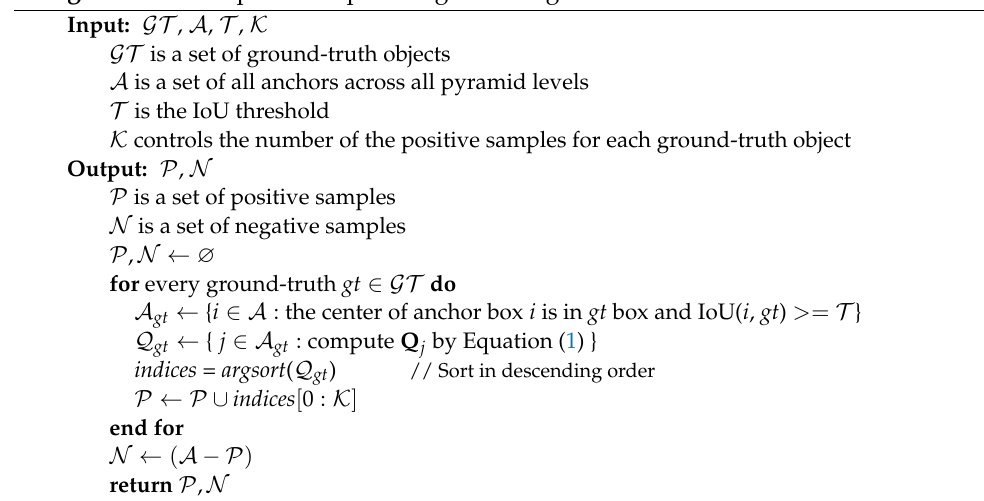
Algorithm 1: Adaptive Sample Assignment